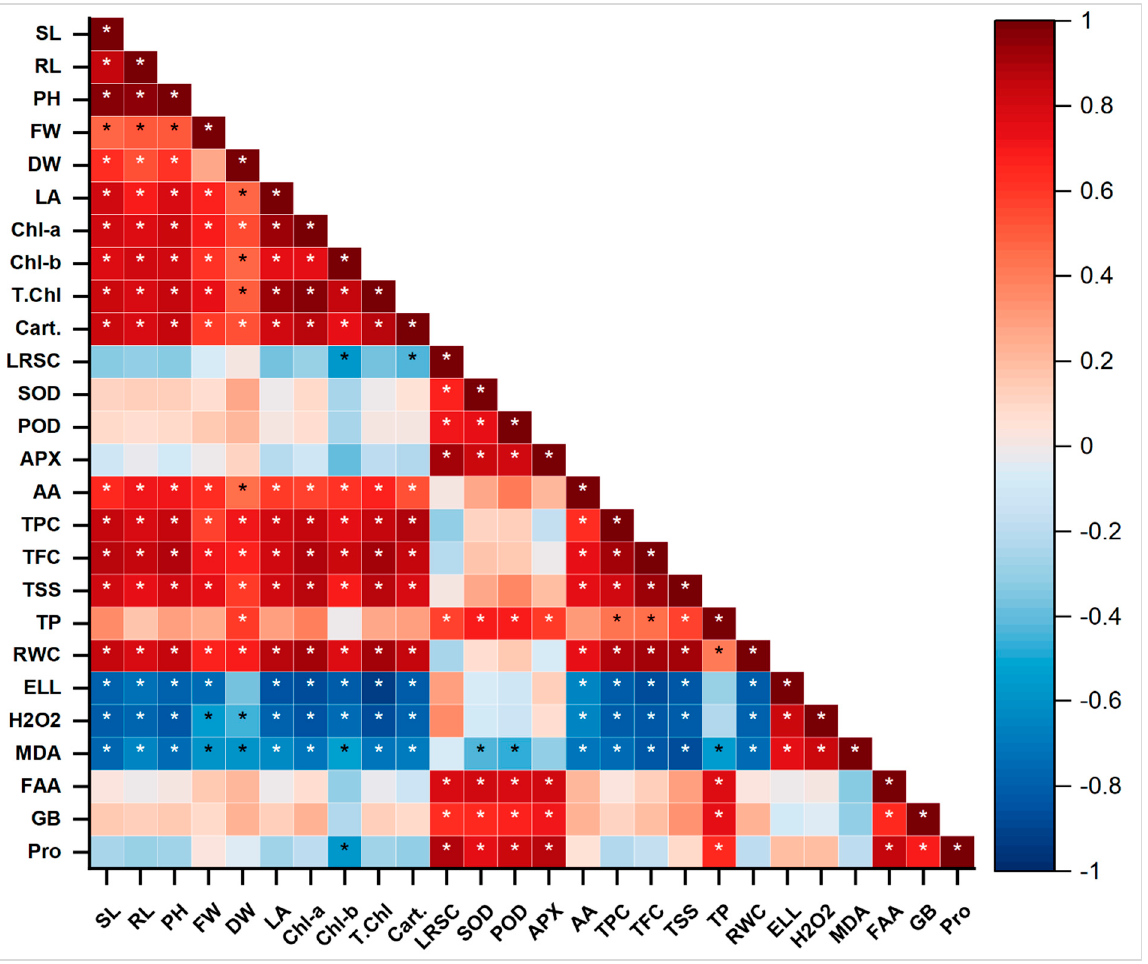
Figure 9. Pearson correlation between antioxidants and biochemical traits with plant biomass parameters under various salt stresses; Pro, (proline), SL (shoot length), RL (root length), PH (plant height), FW (fresh weight), DW (dry weight), LA (leaf area), Chl a (chlorophyll a), Chl b (chlorophyll b), T. chl (total chlorophyll), Caro (carotenoids), DPPH (radical scavenging capacity), SOD (superoxide dismutase), POD (peroxidase), APX (ascorbate peroxidase), AA (ascorbic acid), TPC (total phenolic content), TFC (total flavonoid content), TSS (total soluble sugars), TP (total protein), RWC (relative water content), EL (electrolyte leakage), H 2 O 2 (hydrogen peroxide), MDA (malondialdehyde), FAA (free amino acids), GB (glycine betaine). The treatments exhibit (*) within rows that represent significance ( p ≤ 0.05)